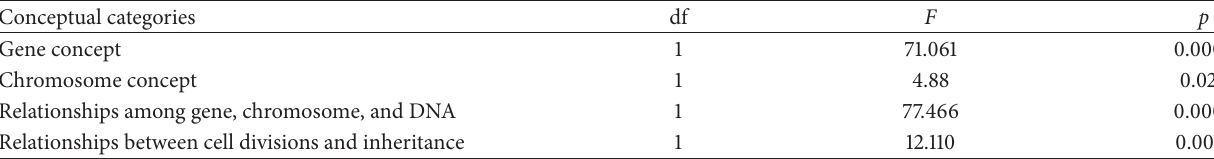
Table 2: Follow-up univariate analyses.